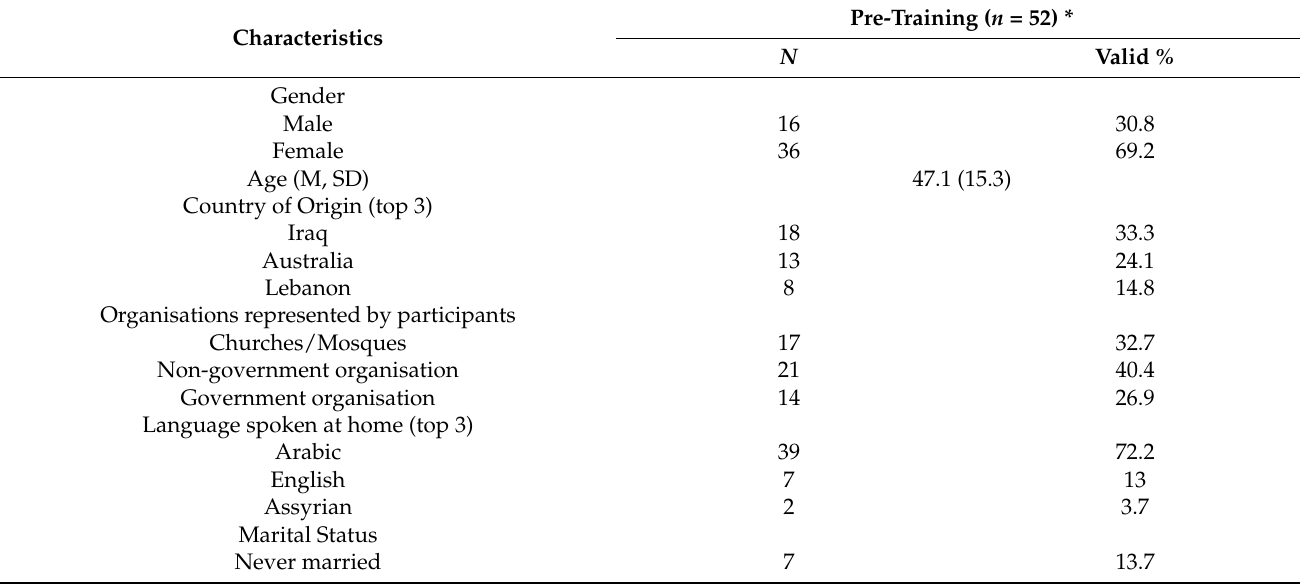
Table 1. Socio-demographic